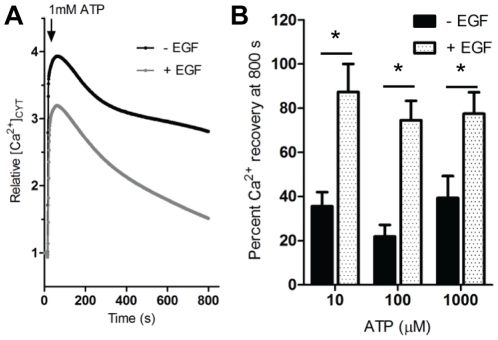
Effect of EGF treatment on the Ca2+ response to ATP stimulation.MDA-MB-468 cells were serum deprived and treated with or without EGF for 24 h as depicted. A, average [Ca2+]CYT transient in cells stimulated with 1 mM ATP. B, [Ca2+]CYT was assessed using 10 µM, 100 µM and 1 mM of ATP. Percent [Ca2+]CYT recovery at the end of the assay (800 s) is shown for each concentration of ATP and represent the averages ± S.D. of 9 wells from 3 independent experiments. Statistical analysis was performed using two-way ANOVA with Bonferroni post-tests; * signifies P<0.05.